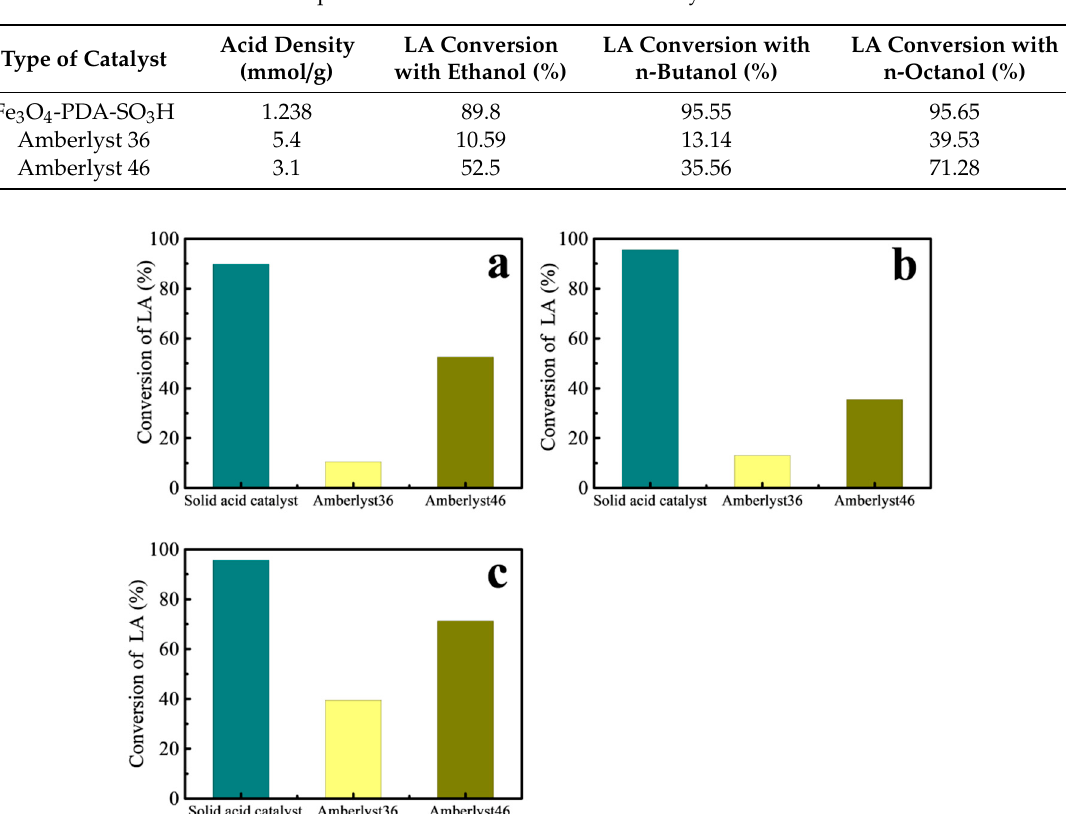
Table 2. Comparison of the e ff ects of di ff erent catalysts on levulinate.